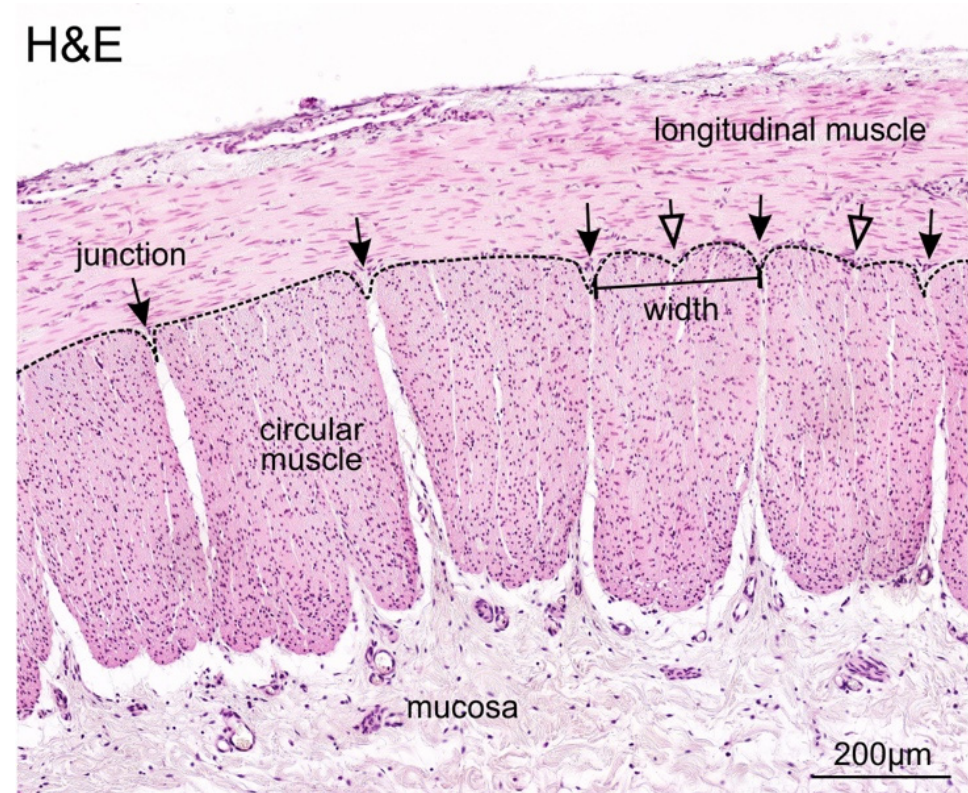
Figure 1. Representative H&E image of the tissue architecture in the transition zone of a long-segment HSCR patient. Circular muscle units are outlined (dotted line), separated at junctions (arrows) where there is a clear depression. Shallow depressions (open arrows) were also present, but were <30 µm in depth, and thus, were identified as being located within muscle units.